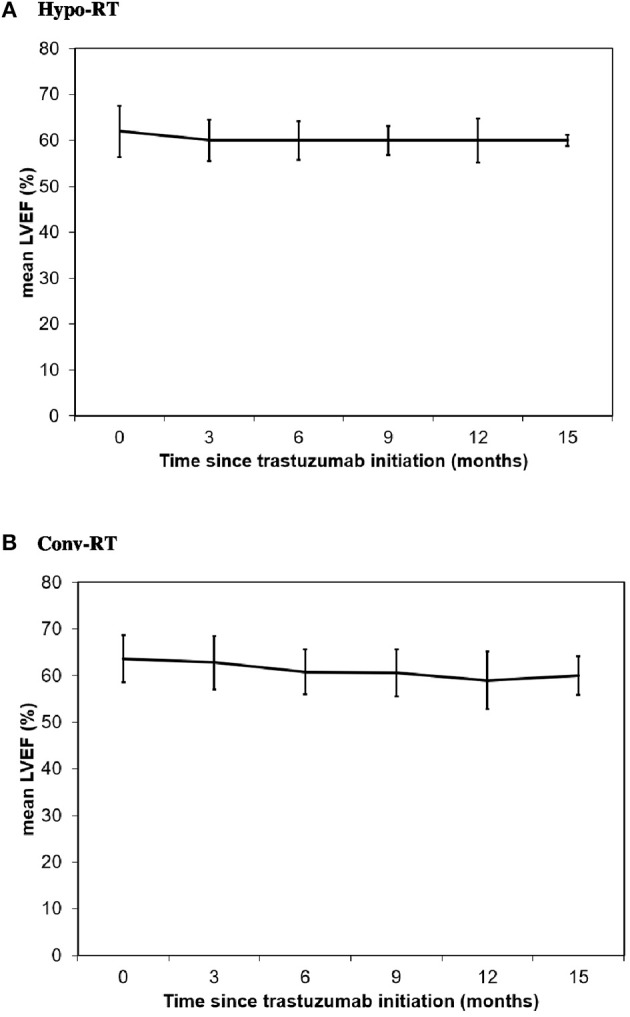
Change in LVEF from baseline in patients treated with Hypo-RT (A) and Conv-RT (B).